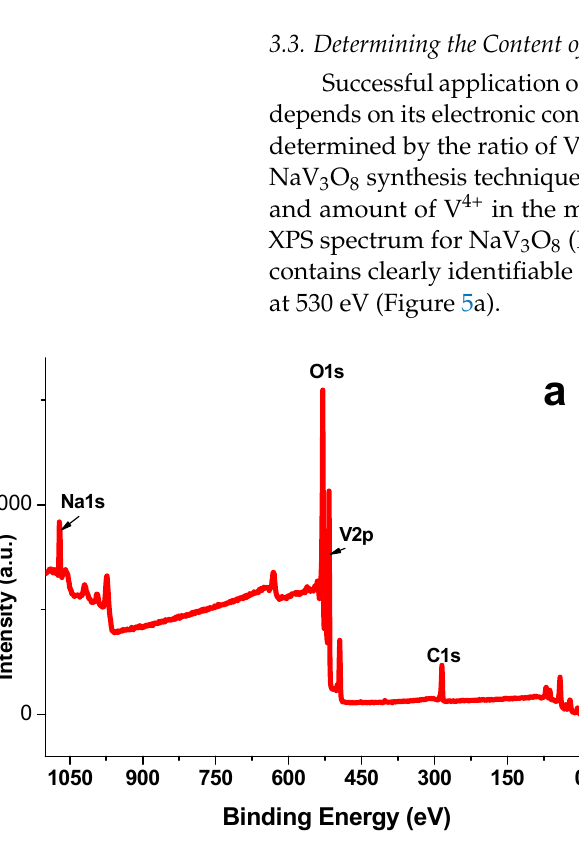
Figure 5. ( a ) Survey XPSspectrum forNaV 3 O 8 ; ( b ) high-resolution XPS spectrum for V 2p inNaV 3 O 8 . The high-resolution XPS spectrum for V 2p (Figure 5b) contains clearly identifiable peaks at 517.15 and524.48 eV, which can be ascribed to the spin-orbit splitting of V 5+ 2p3/2 and V 5+ 2p1/2, respectively [30]. Besides, there are peaks at 515.63 eV (V 4+ 2p3/2) and 523.13 eV (V 4+ 2p1/2) assigned to V 4+ . The content of V 4+ and V 5+ , calculated from the areas of the peaks, was found to be 8% and 92%, respectively. Synthesis of NaV 3 O 8 via aqueous solution yielded the values of 7% and 93% for V 4+ and V 5+ , respectively [21]. A slightly higher content of V 4+ in the case of solid-state synthesis may be related to partial reduction of V 5+ to V 4+ by the ammonia released during thermal decomposition of NH 4 VO 3 [22].